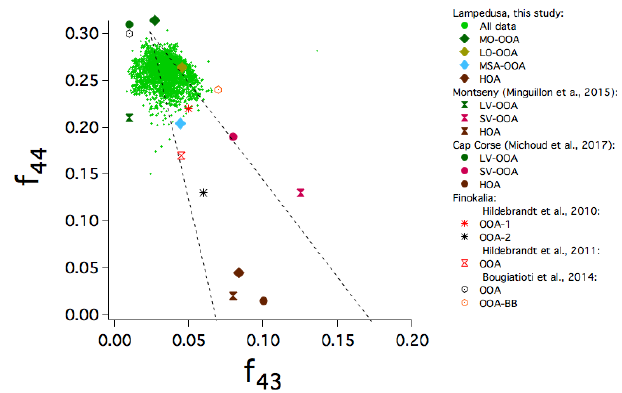
Figure 9. f 43 (the ratio of m/z 43 to the total OA) against f 44 (ratio of m/z 44 to the total OA). The triangle is considered to encapsulate typical atmospheric values of OA according to Ng et al. (2010). The values for the various PMF factors from this study and other studies conducted in the remote Mediterranean are also